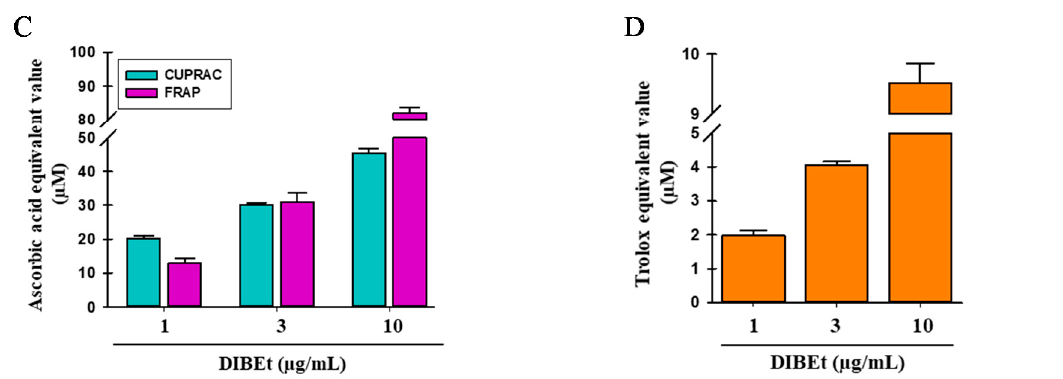
Figure 3. Radical-scavenging effects of DIBEt. DPPH and ABTS ( A ) and superoxide and hydroxyl ( B ) radical-scavenging activities of DIBEt. Ascorbic acid (ASC) and quercetin (QRC) were considered as standard antioxidant molecules. The reducing power of DIBEt was examined by CUPRAC, FRAP, and ORAC assays ( C ). The ascorbic acid-equivalent antioxidant capacity was calculated for CUPRAC and FRAP assays, and ( D ) the ORAC activity was expressed as the Trolox-equivalent antioxidant capacity. Mean ± SD ( n = 3). ** p < 0.01.